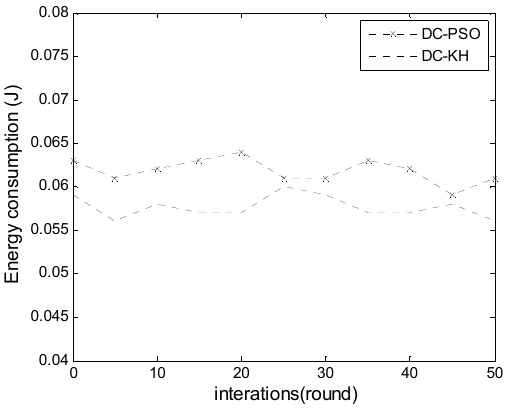
Figure 3. Energy consumption comparison chart of the main-cluster head.